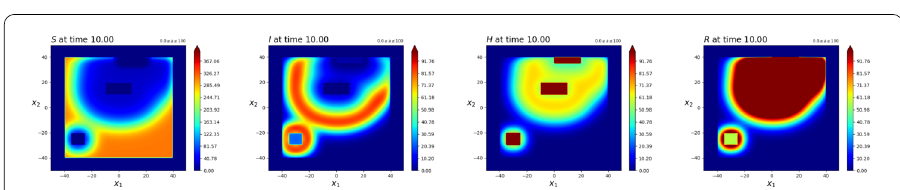
Figure 11 Contour plots of the solution to the “CareHomes” integration at time t = 10. The front of the pandemic clearly spreads from the top right towards the bottom left of the domain and now the care house C 2 , as defined in (12), acts as an epidemic outbreak, opening a second front and accelerating the pandemic in the lower left part of the domain